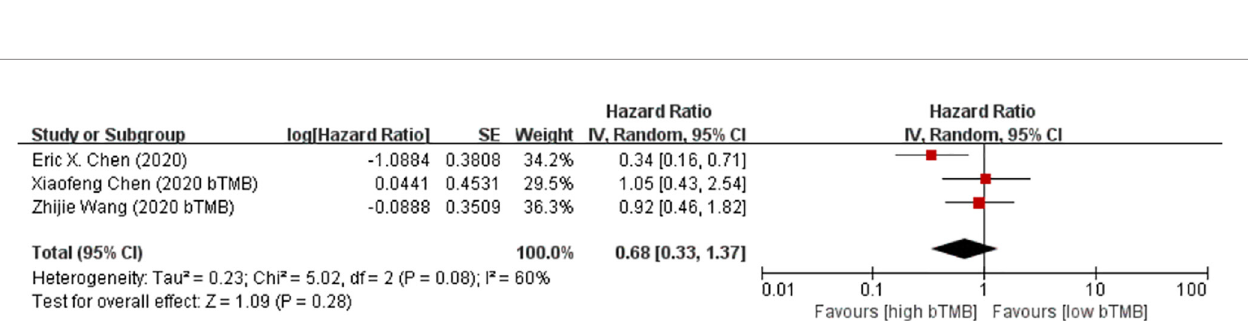
FIGURE 6 | Forest plot of the fi xed effects meta-analysis on the ef fi cacy of circulating DNA (ctDNA) for progression-free survival (PFS) at different time points.